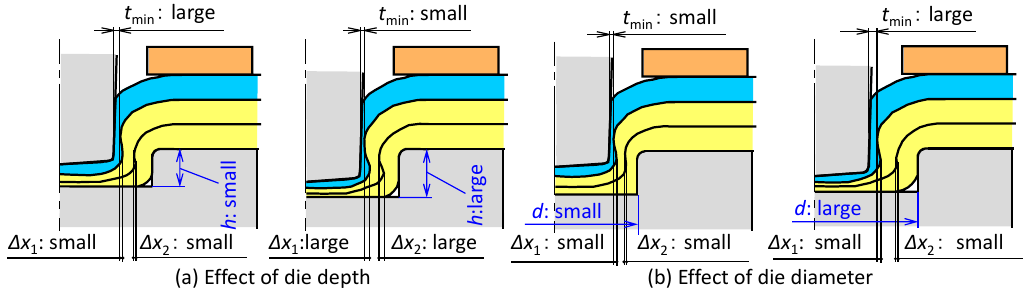
Figure 16. Effects of die shape on the deforming behavior of sheets: ( a ) die depth; ( b ) die diameter.